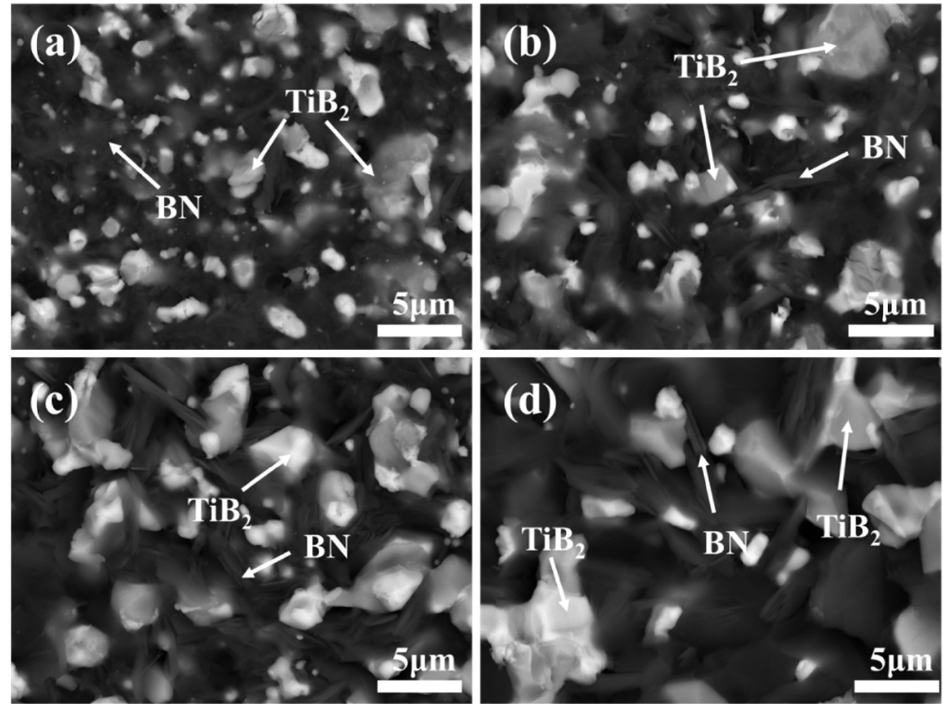
Figure 5. BSE photos of TiB 2 -BN-SiC composite ceramics with four TiB 2 -SiC volume ratios: ( a ) 3:1, ( b ) 6:1, ( c ) 9:1, and ( d ) 12:1.